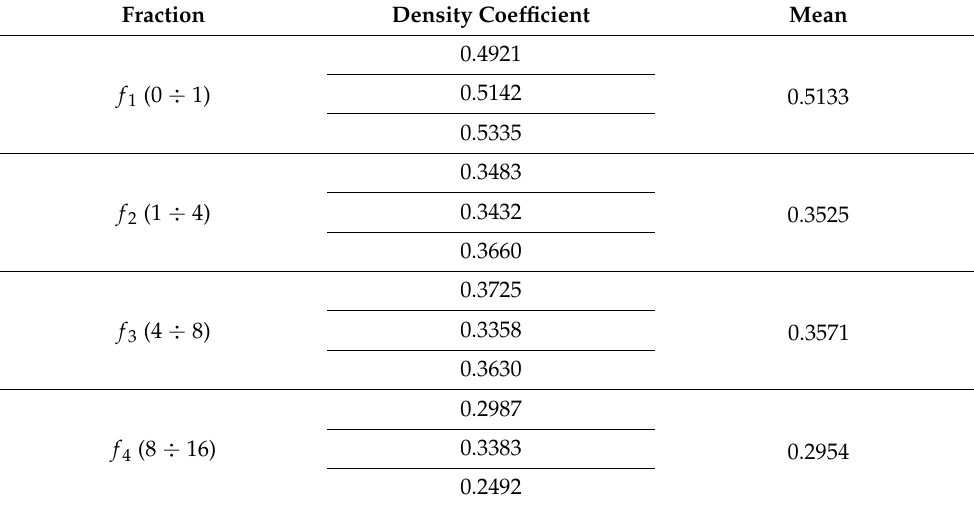
Table 2. Breakdown of parameters for respective